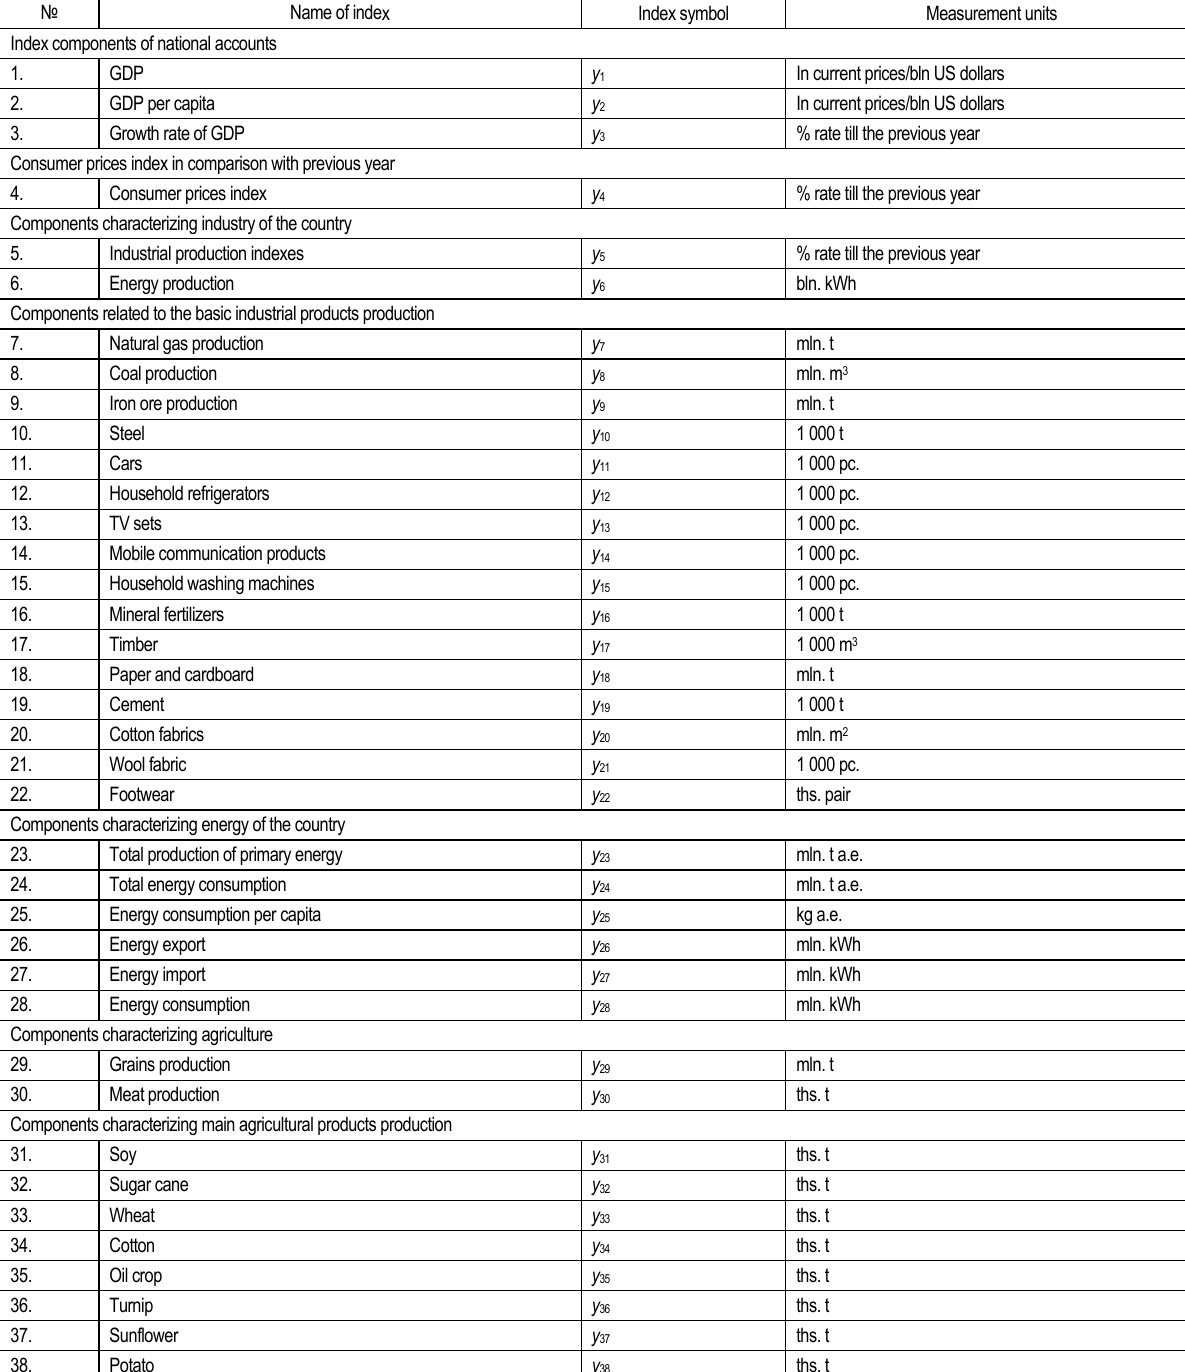
Table 1. The list of indexes characterizing socioeconomic state of countries in terms of integration